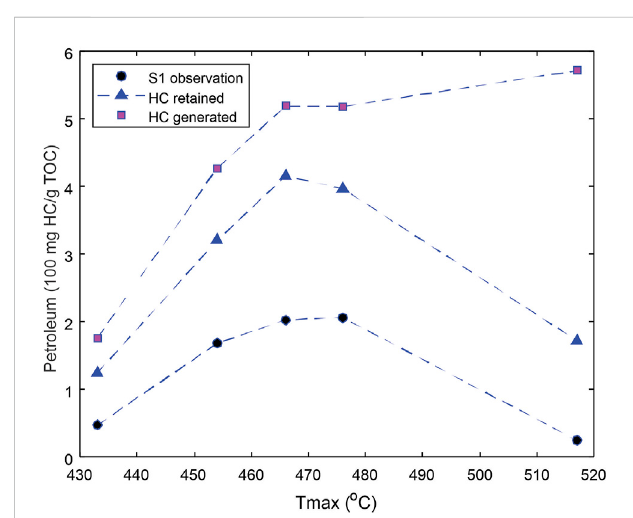
FIGURE 7 Comparison of observed S1 (free petroleum remained in samples) with retained petroleum (TOY de fi ed by Eq. 1) that is the total quantity of petroleum corrected from light hydrocarbon loss. The total petroleum generated is shown as a